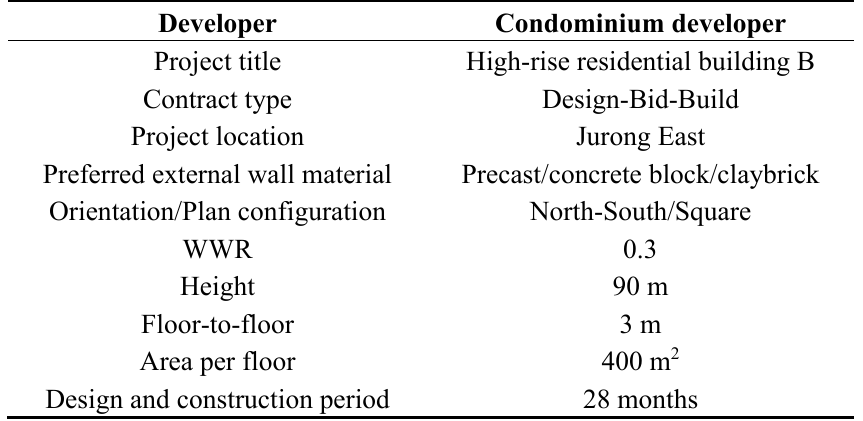
Table 2. General project information.